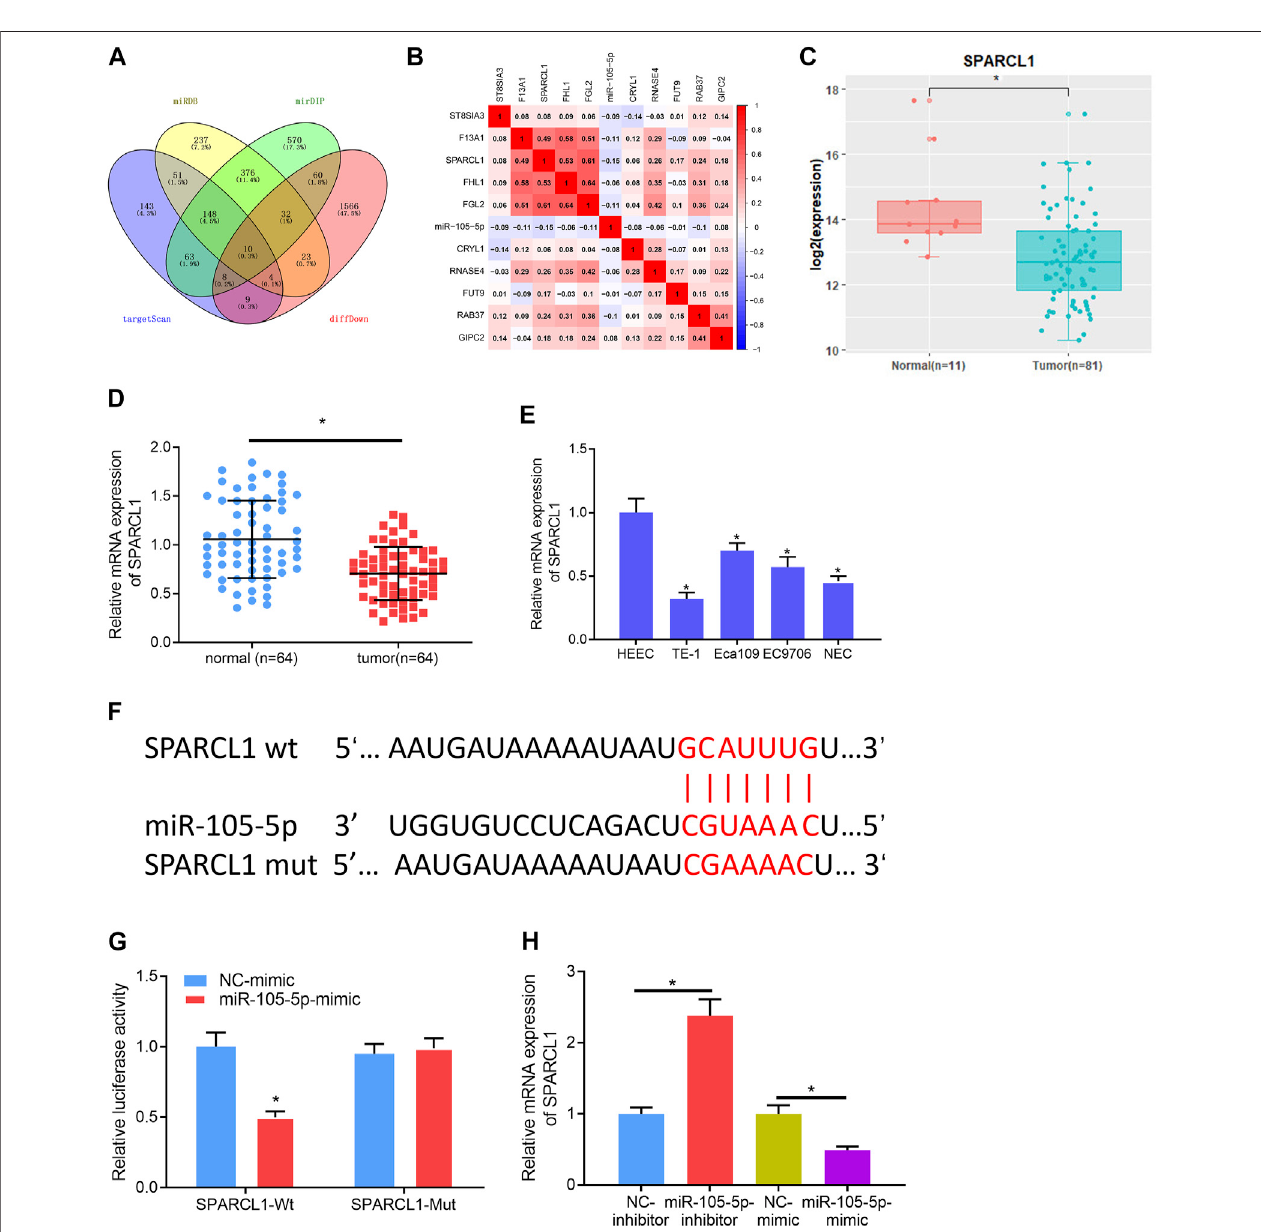
FIGURE 3 | SPARCL1 is the direct target of miRNA-105-5p. (A) Venn diagram of downregulated DEmRNAs and the predicted target mRNAs of miRNA-105-5p; (B) Correlation of miRNA-105-5p and the 10 overlapping mRNAs; (C) SPARCL1 expression in TCGA-ESCC dataset; (D) SPARCL1 expression in cancer and adjacent normal tissue; (E) SPARCL1 level in normal human esophageal epithelial cell line and ESCC cell lines; (F) Putative binding sites between miRNA-105-5p and SPARCL1; (G) Thetargeting relationshipbetweenmiRNA-105-5pand SPARCL1; (H) Theeffect ofsilencing/overexpressingmiRNA-105-5pinESCCcellsonSPARCL1level; * p < 0.05, ** p <